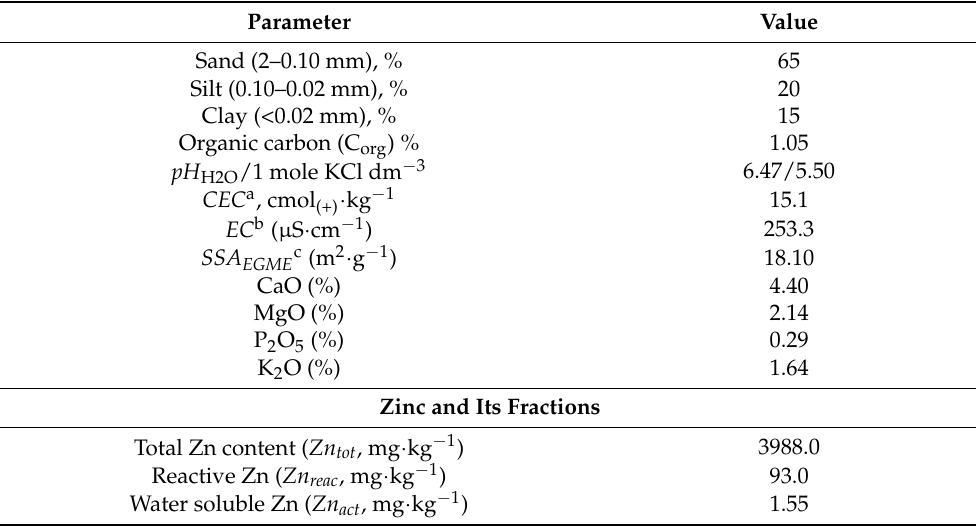
Table 1. Physical and chemical characteristics of the Zn-polluted soil.